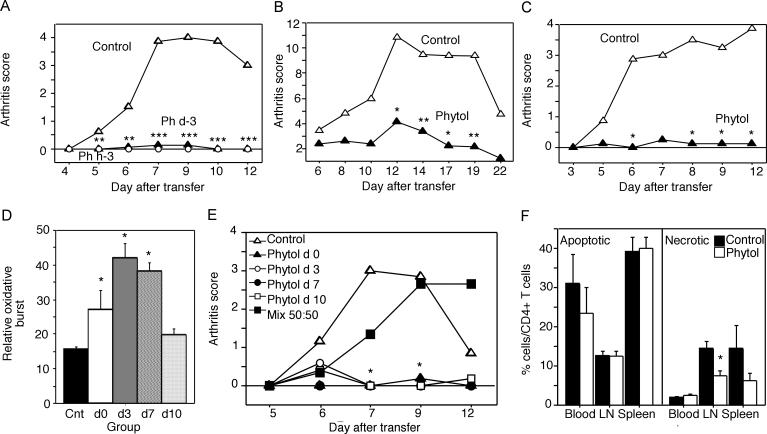
Phytol Inhibits Arthritogenic T Cells In Vivo(A) Phytol (Ph) prevents adoptive transfer of arthritis when injected into the recipient DA.Ncf1
DA rat before onset. Phytol was injected (200 μl SC) in the recipient 3 d or 3 h before transfer of arthritogenic T cells from pristane injected DA.Ncf1
DA rats (control, n = 8; phytol, n = 16).(B) Phytol ameliorates arthritis also when injected in recipient DA.Ncf1
DA rats after disease onset. Phytol was injected (200 μl SC) in the recipient rats days 5 and 8 after transfer of arthritogenic T cells (control n = 7 and phytol n = 8).(C) Phytol inhibits arthritogenic T cells when injected in the donor DA.Ncf1
DA rat. Spleen cells from phytol treated (500 μl SC day −5) rats were taken day 10 after pristane injection, transferred into naïve DA.Ncf1
DA rats and the effect of phytol on the development of arthritogenic T cells were followed (n = 8).(D, E) Phytol has a rapid inhibitory effect on arthritogenic T cells. The time-point for the effect of phytol was titrated by administration of phytol (500 μl SC) on different days after pristane injection (day 0). Day 10 after pristane, donor spleens (DA.Ncf1
DA) were taken and analyzed for oxidative burst of granulocytes (n = 3) (D) and the cells transferred into naïve DA.Ncf1
DA recipient rats. The rats were then monitored for arthritis symptoms (E). Cells from rats treated day 0 and control rats were also mixed (50:50) to investigate a possible dominating effect of phytol treatment (control [Cnt], n = 6; phytol, n = 5; and mix, n = 3).(F) Phytol does not induce acute cell death. Percentage of apoptotic (Annexin V+ and PI−) and necrotic (Annexin V+ and PI+) CD4+ cells ex vivo 3 h after phytol (n = 5).*p < 0.05, **p < 0.01, ***p < 0.001.